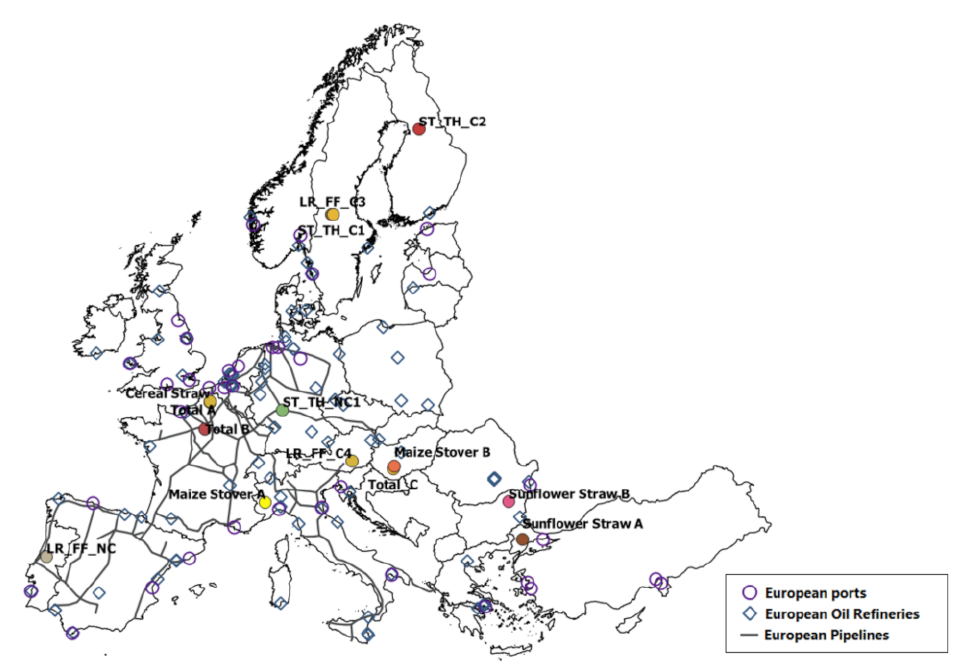
Figure 3. Hotspots and infrastructure localities for fuel production. (European map used as an